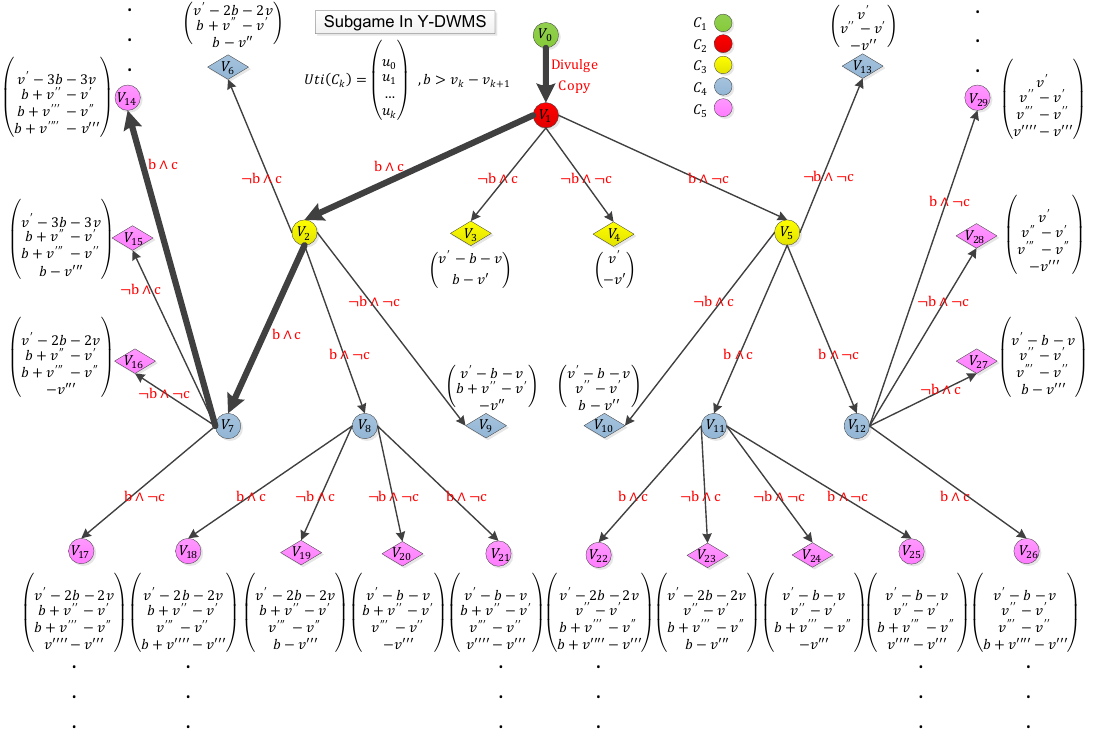
Figure 5. The subgame will be triggered if a digital copy is